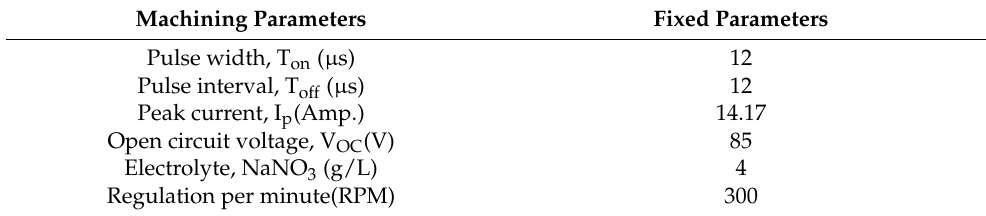
Table 2. Machining parameters for electrochemical discharge machining (ECDM) experiments for brass, TC4, SS304, W70Cu30, W80Cu20, and W90Cu10